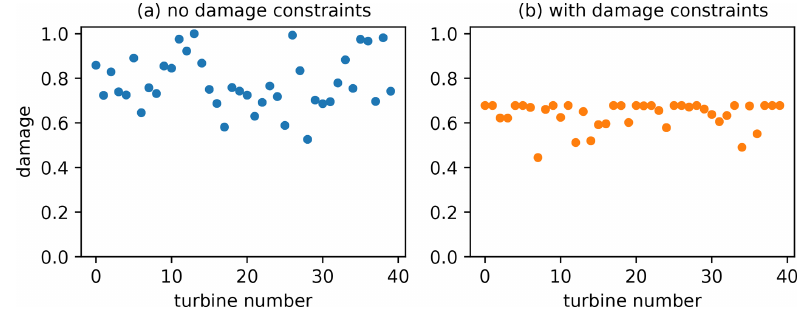
Figure 17. The fatigue damage of each turbine in our wind farm layout optimizations. On the left are (a) the damages for the wind farm layout optimized without damage constraints, while on the right are (b) the damages with the maximum damaged constrained to be less than 0.04. These plots have been normalized by the maximum turbine damage in the layout optimized with no damage constraints. On the right, the line of maximum damages around 0.7 is the normalized damage constraint of